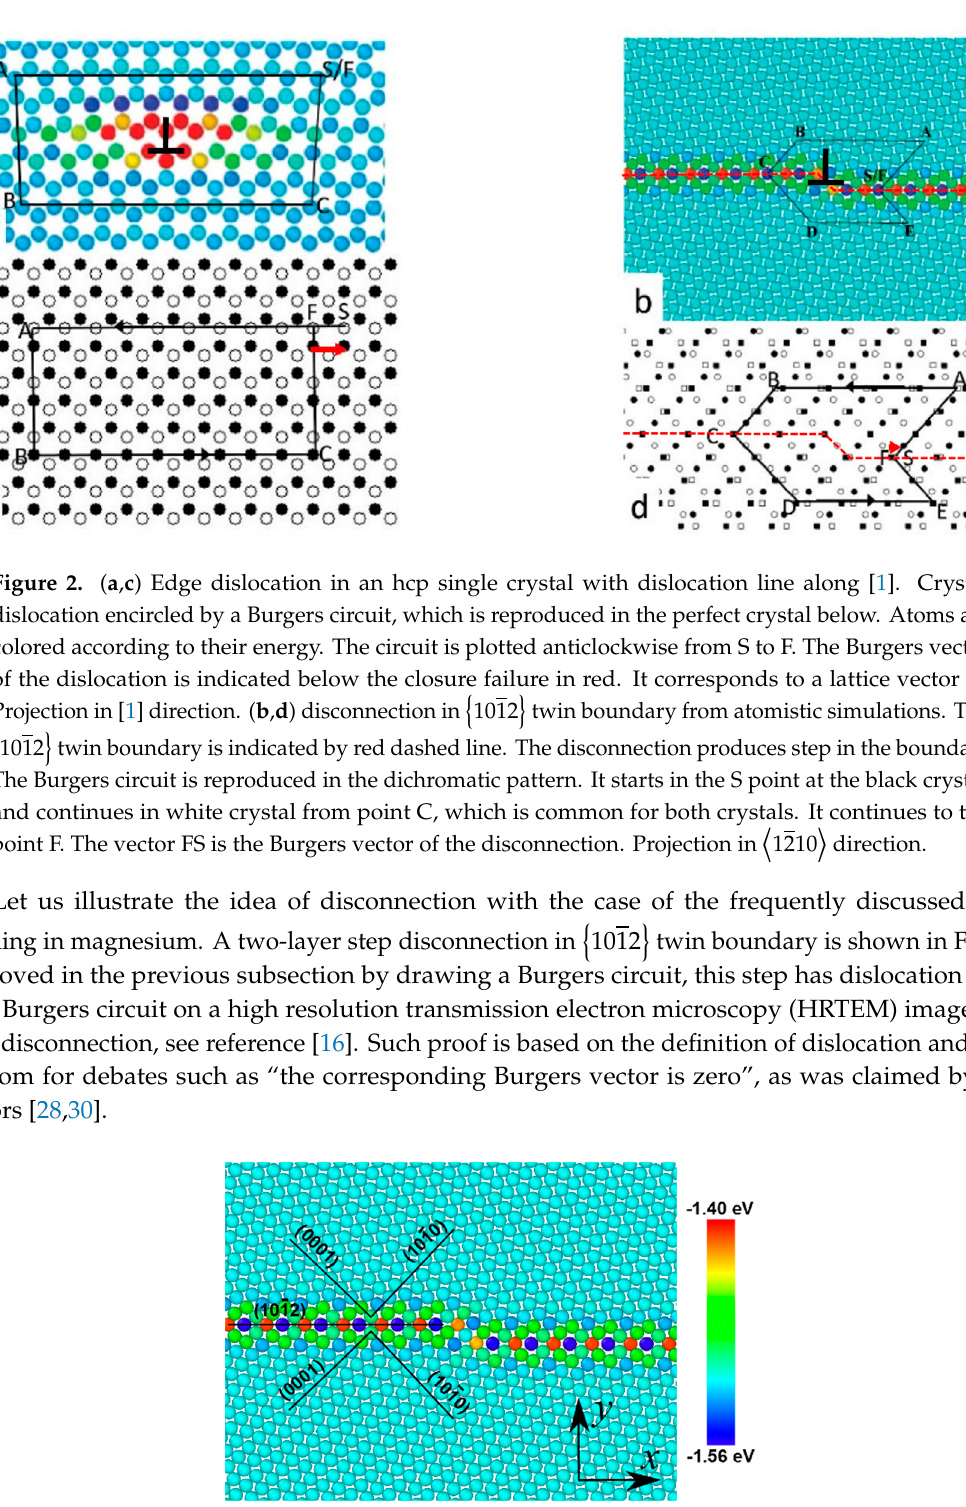
Figure 3. Disconnection in {1012} twin boundary from atomistic simulations. The atoms are coloured according to their energy. Twin boundary lies along the plane containing red and dark blue atoms. The disconnection is settled in the step on the boundary. (Reproduced from [12], with permission from IOP publishing, 2014).